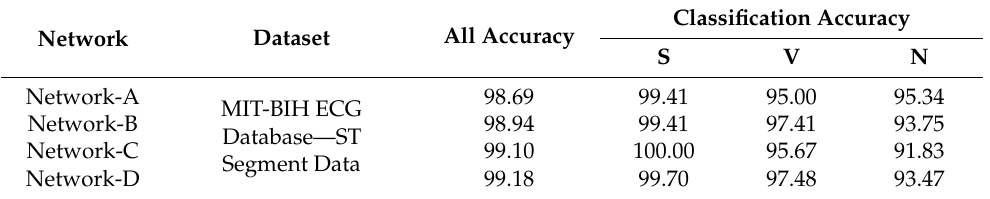
Table 5. Test results of all networks on type III data.